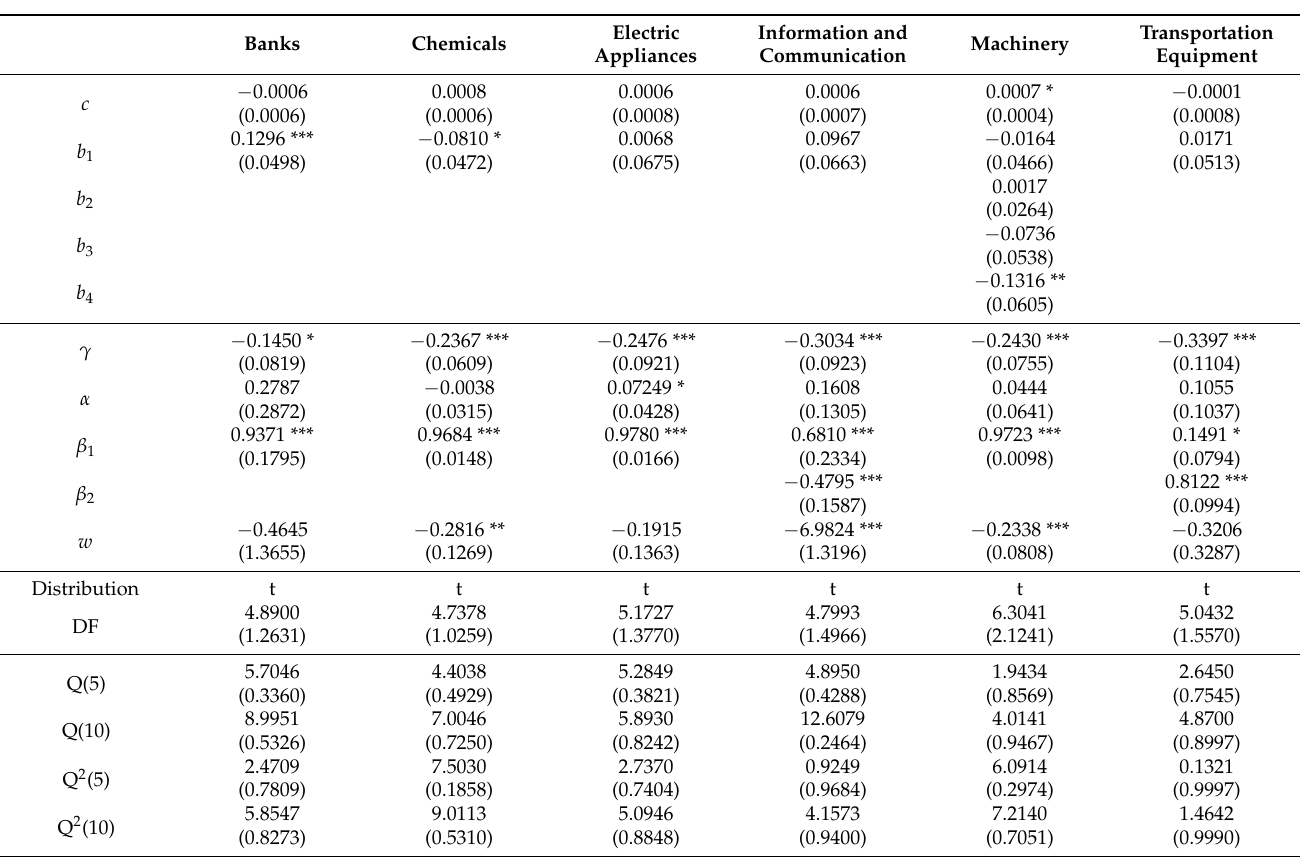
Table 3. EGARCH estimation for sectoral indices. Author’s estimations based on data from the Bank of Japan, TSE, and Yahoo Finance. The numbers in parentheses are standard errors. ***, **, and * indicate significance at the 1%, 5%, and 10% levels, respectively. Distribution is Student’s t. DF means the degree of freedom. Q (5) and Q (10) (and squared Q (5) and Q (10)) are the Ljung–Box Q statistics for the null hypothesis of no autocorrelation of up to orders 5 and 10 for the standardised residuals (and squared standardised